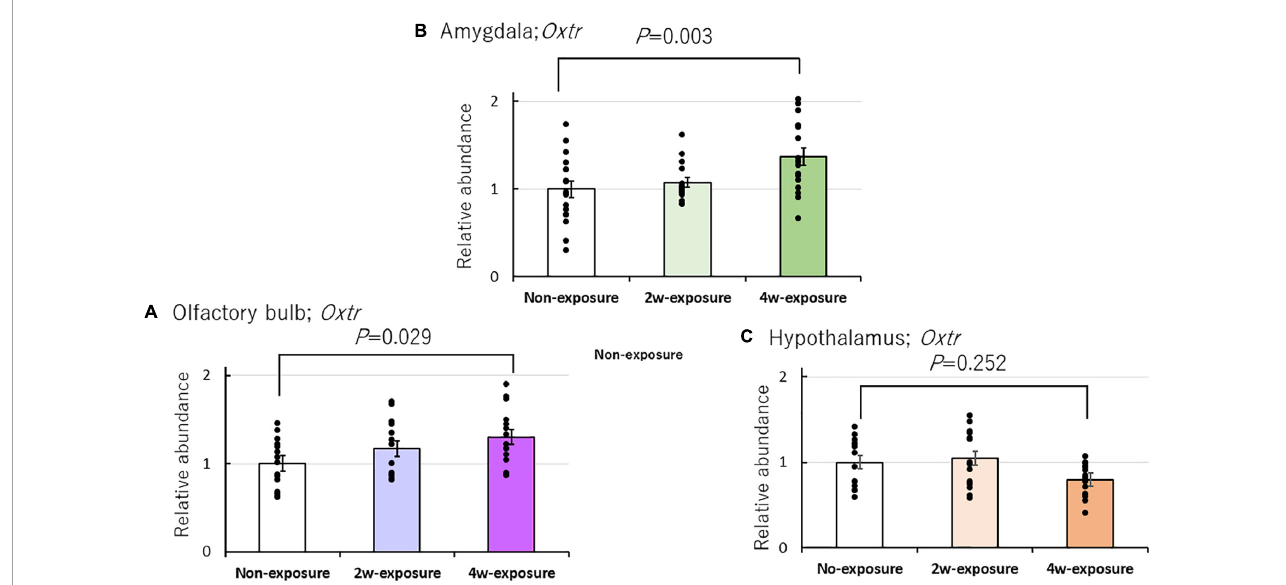
FIGURE5 Effects of repeated coffee odor exposure on Oxtr mRNA expression in the three brain areas. Effects of odor stimulation on Oxtr mRNA expression in the olfactory bulb (A) , the amygdala (B) , and the hypothalamus (C) . Black dots describe individual data. The bar graphs show the mean ± SE. The statistical significance ( P < 0.05) of the difference between genes in the non-exposure, 2-week, or 4-week exposure groups was tested by two-factor ANOVA followed by a Bonferroni post-hoc test.